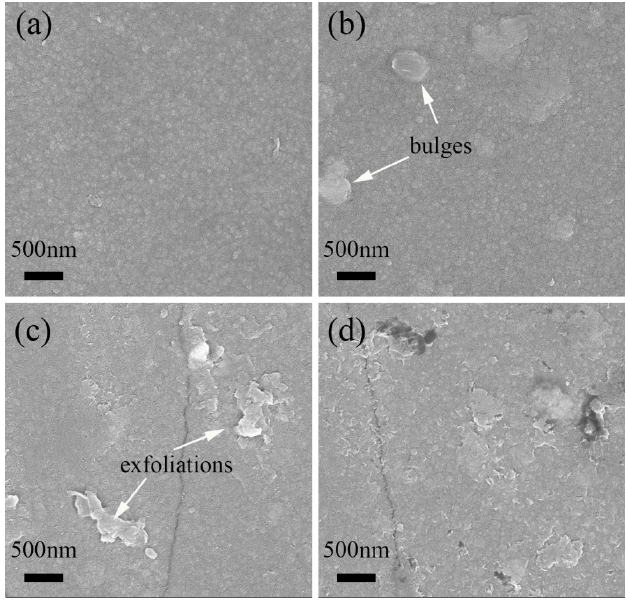
Figure 8. Scanning electron microscopy (SEM) images showing the surface morphology of the prepared 3C-SiC/ZrO 2 films ( a ) and the 3C-SiC/ZrO 2 films corroded at 100 °C water bath for 0.5 h ( b ); 10 h ( c ) and 30 h ( d ).